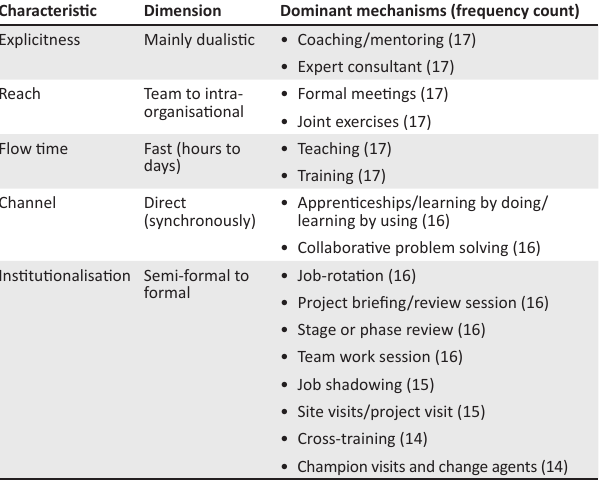
TABLE 11: Cluster 2 main characteristics and dominant knowledge transfer mechanisms. Characteristic